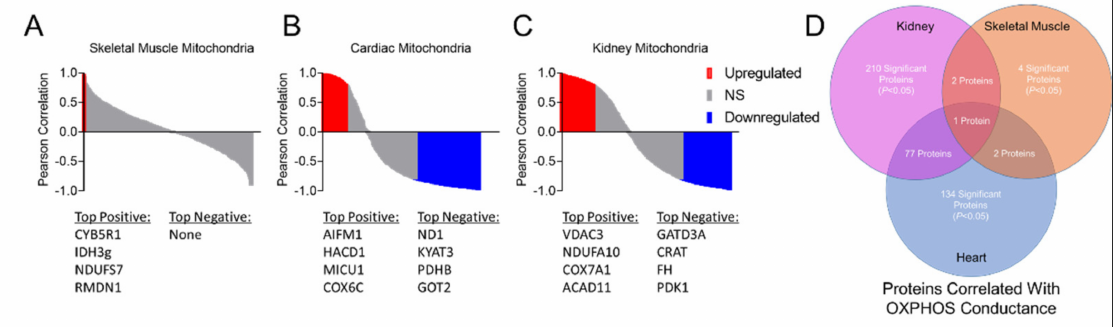
Figure 7. Association between the mitochondrial protein abundance and OXPHOS conductance. Pearson correlations between protein abundance and OXPHOS conductance for ( A ) skeletal muscle; ( B ) cardiac muscle; and ( C ) renal tissue mitochondria in control and CKD mice ( n = 3/group/tissue). Pearson correlations with p < 0.05 are shown in red (positive) and blue (negative). Top positive (red) and negative (blue) correlating proteins are listed below each graph. ( D ) Venn diagram of all the significantly correlated proteins to OXPHOS conductance show common and distinct associations across